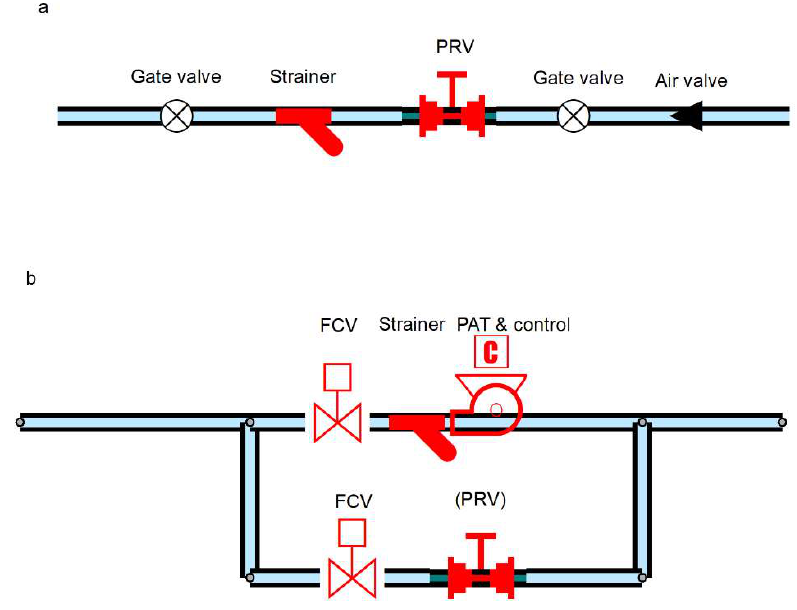
Figure 2. Installation scheme of a Pressure Reducing Valve (PRV) ( a ) and of a Pump As Turbine (PAT) ( b ).